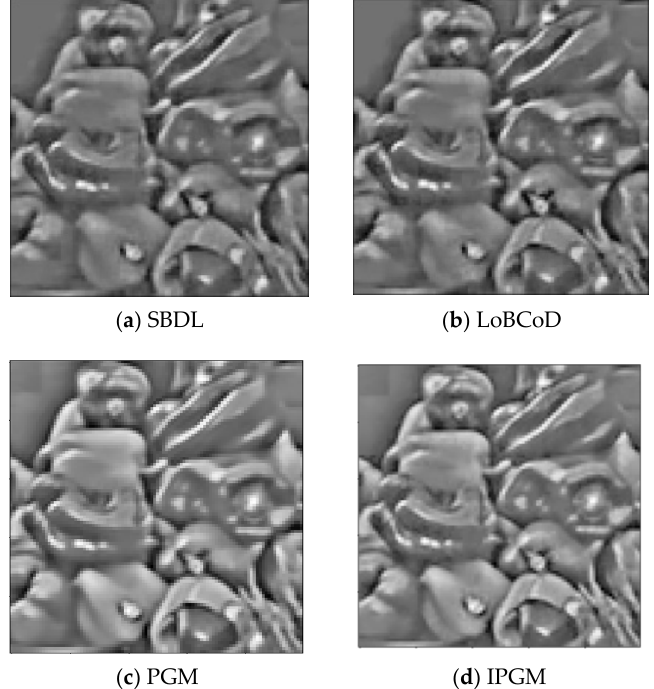
Figure 3. Reconstruction images yielded by all compared methods after 1000 iterations from the grayscale natural fruit images. ( a – d ) is the reconstruction images yielded by SBDL, LOBCOD, PGM, IPGM, respectively.